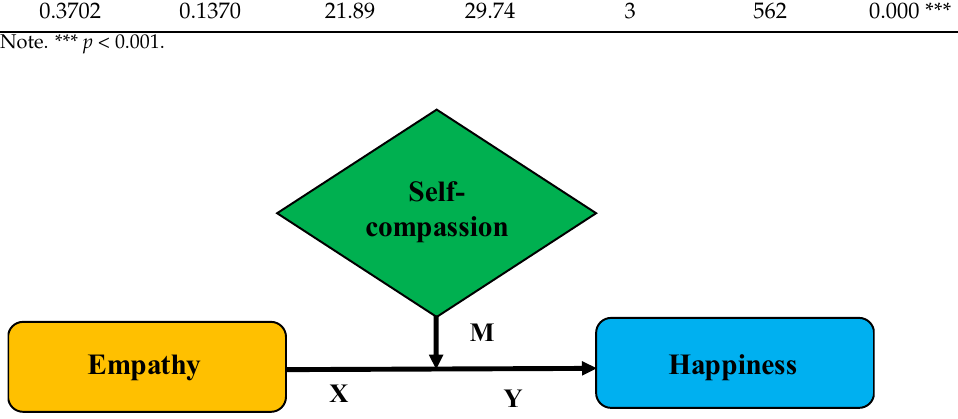
Figure 3. Conceptual model of self-compassion